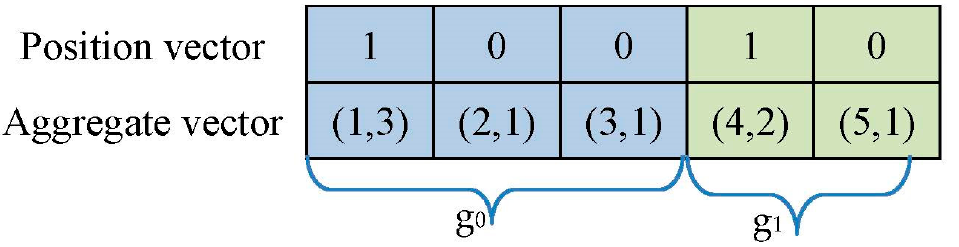
Figure 7. The aggregate vector of position vector .